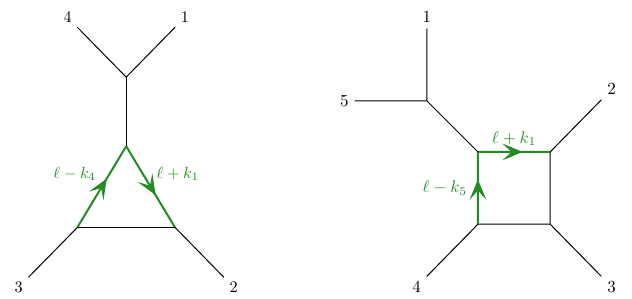
Figure 2 . Examples of diagrams for four and (cid:12)ve particles that do not contribute to the single cut. This is due to the BCFW shift (2.3), which leaves all loop propagators in these diagrams invariant, e.g. ^ ‘ + ^ k 1 = ‘ + k 1